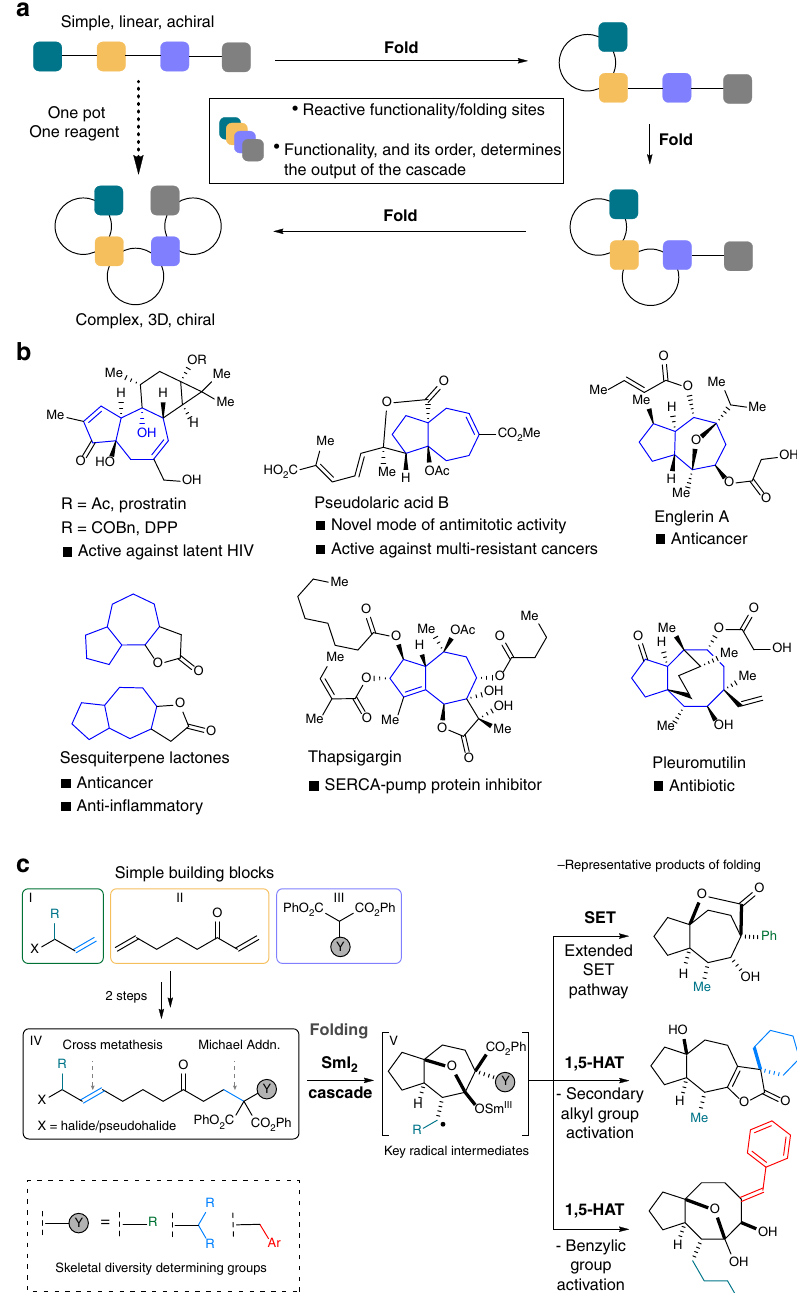
Fig. 1 A folding cascade approach that delivers polycyclic architectures and the samarium(II) folding cascade approach. The folding cascade approach, examples of biologically active natural products bearing [5,7] and [5,8] fused bicyclic motifs, and a samarium(II)-mediated, one-pot cascade reaction enabling access to these architectures, are shown. a Folding cascade approaches convert simple, linear starting materials to complex 3D polycyclic architectures through the sequential action of a single reagent on functional groups arranged in the substrate to be folded. b Biologically relevant natural products possessing multiple stereocentres and sites of oxygenation, and [5,7] or [5,8] ring systems include prostratin, pseudolaric acid B, englerin A, sesquiterpene lactones such as thapsigargin, and pleuromutilin. c This work involves the development of a one-pot approach to complex polycyclic architectures from simple starting materials. The approach exploits samarium(II) folding cascades featuring 1,5-HAT functionalisation of tertiary and benzylic C – H